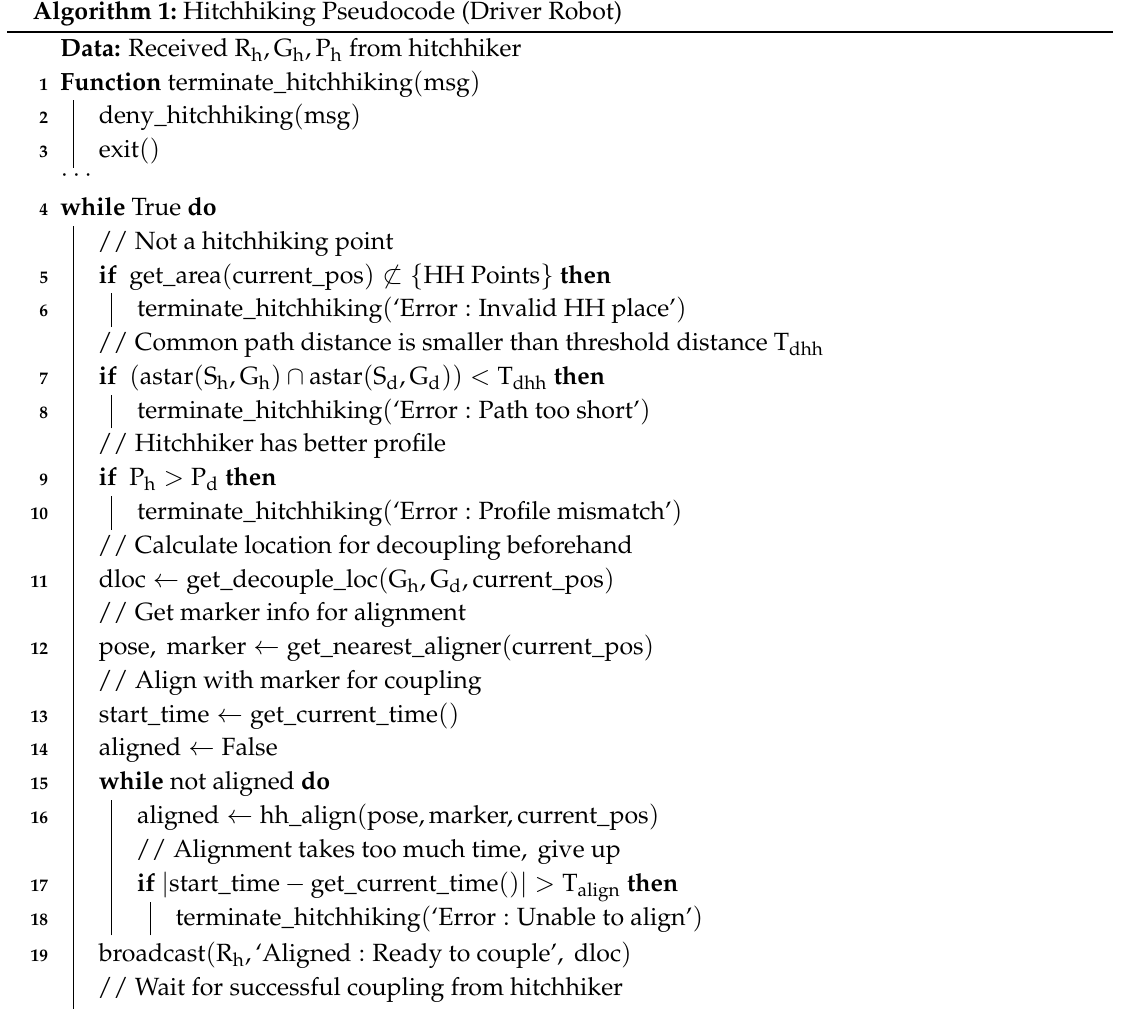
Algorithm 1: Hitchhiking Pseudocode (Driver